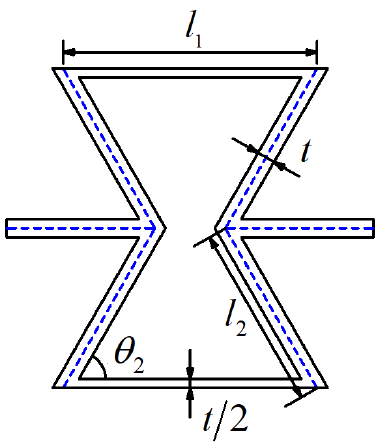
Figure 4. Geometrical configuration of a re-entrant honeycomb cell.